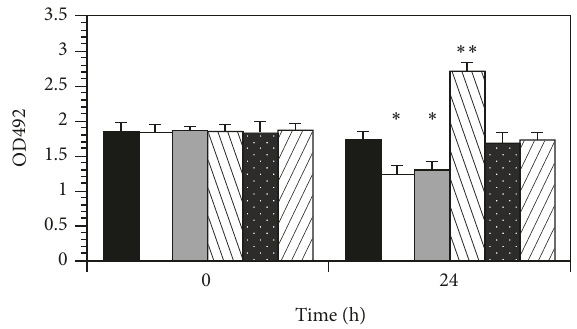
Figure 5: EIA analyses of strain NU149 grown in a pH 5.5 or 7 environment mixed with plain Sepharose beads, mannose-coated Sepharose beads, or mannose-coated Sepharose beads with 2% free mannose (wt/vol) added. Columns represent NU149 grown in pH 5.5 LB mixed with mannose-coated Sepharose beads (black column),plainSepharosebeads(whitecolumn),ormannose-coated Sepharose beads plus 2% free D-mannose (gray column) as well as NU149 grown in pH 7 LB mixed with mannose-coated Sepharose beads (left striped column), plain Sepharose beads (white dots col- umn), or mannose-coated Sepharose beads plus 2% free D-mannose (right striped column). Optical densities at 492 (O.D. 492 ) were determined. The data represents the means ± standard deviations from at least three separate experiments. ∗ equals 𝑃 < 0.05 and ∗∗ equals 𝑃 <